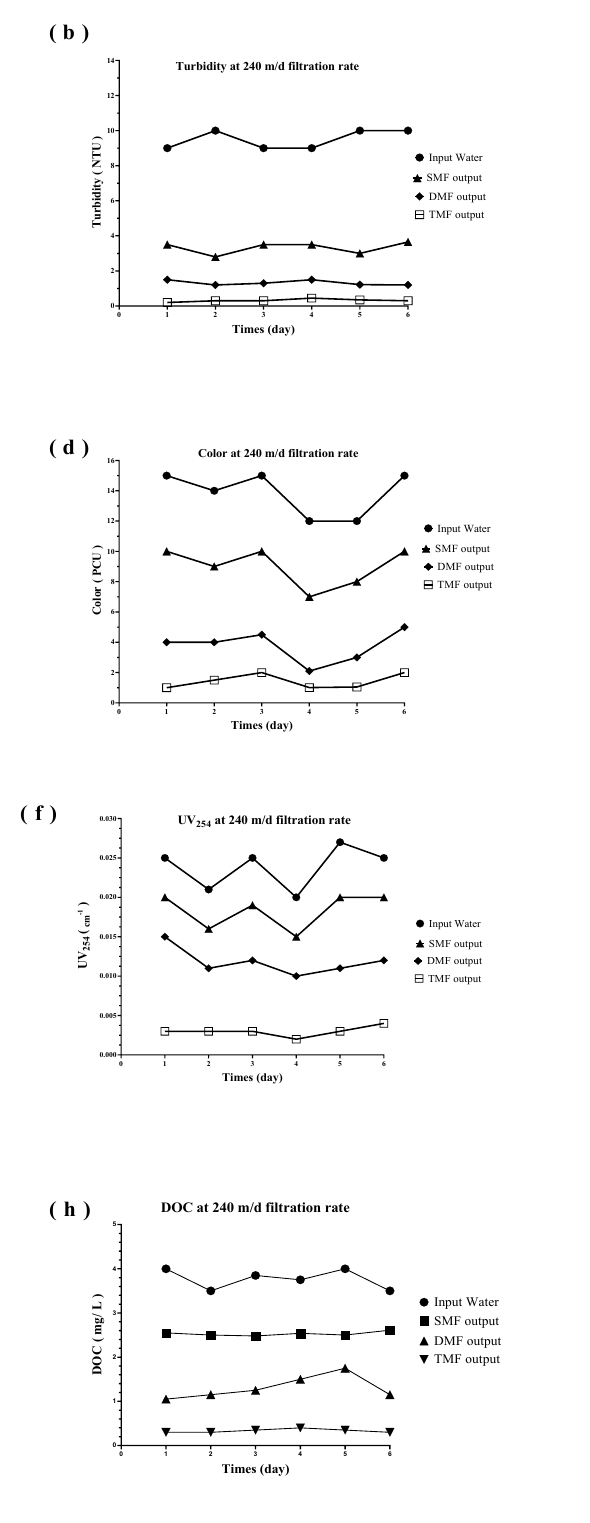
Figure 2. The chart of turbidity, color, UV media filters at different filtration